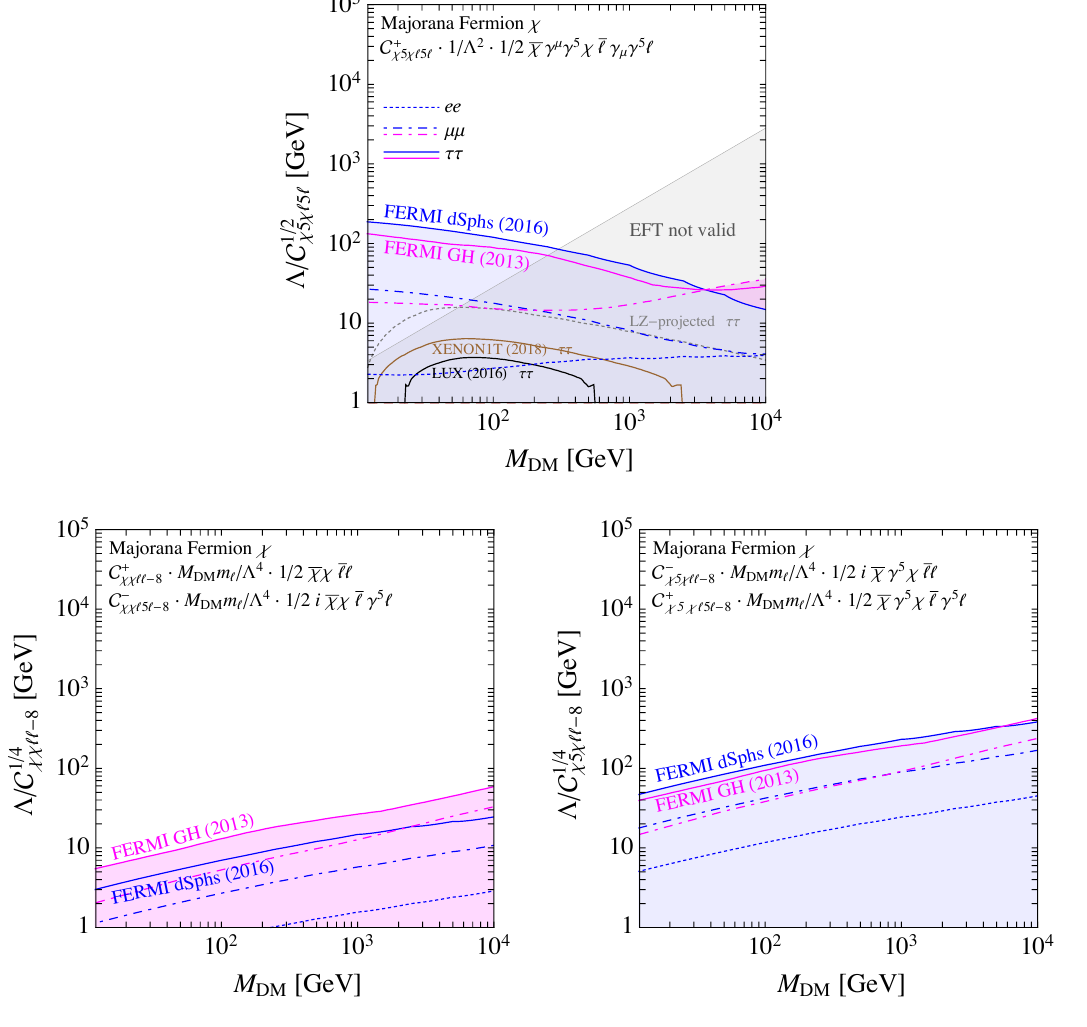
Figure 5 . Same as (cid:12)gure 4 but for the UV-related operators for Majorana Fermion (cid:31) . These constraints should be compared with the corresponding constraints from DM-photon operators shown in (cid:12)gure